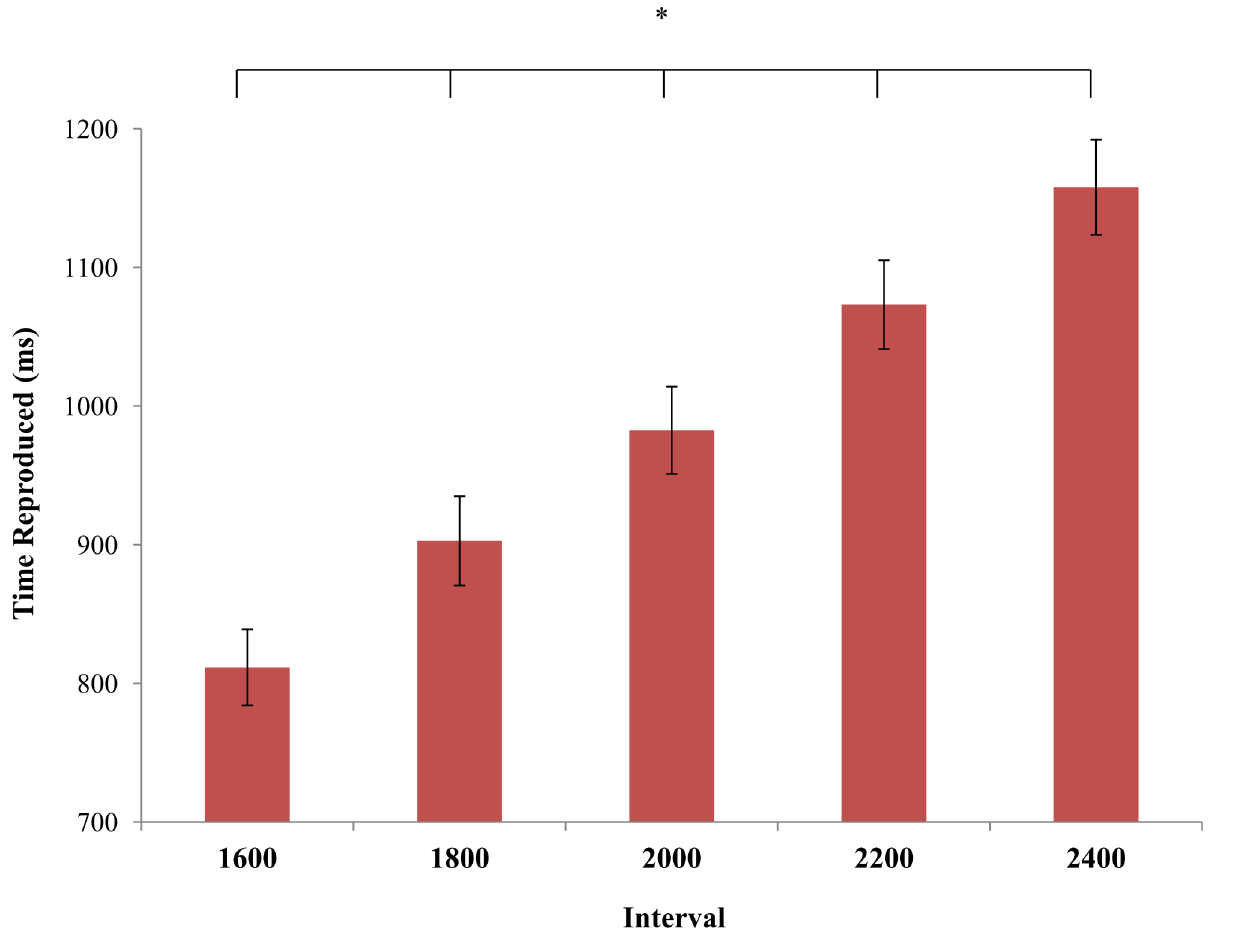
Fig 2. Interval effect. Values are in ms and error bars depicted SEM. Asterisks indicate significant differences (p < .05).